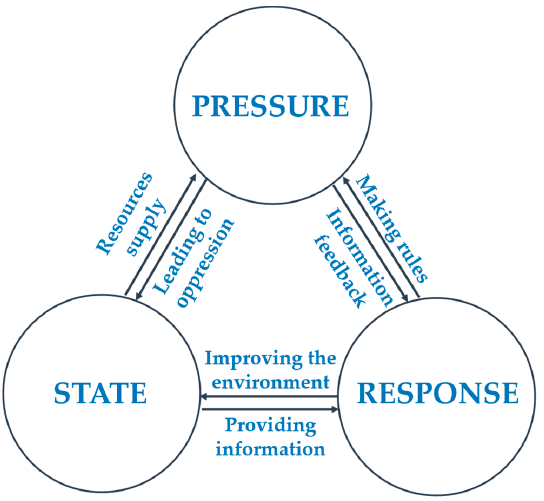
Figure 4. The framework of the PSR model. Source: Summarized by the authors according to the literature [35–37].